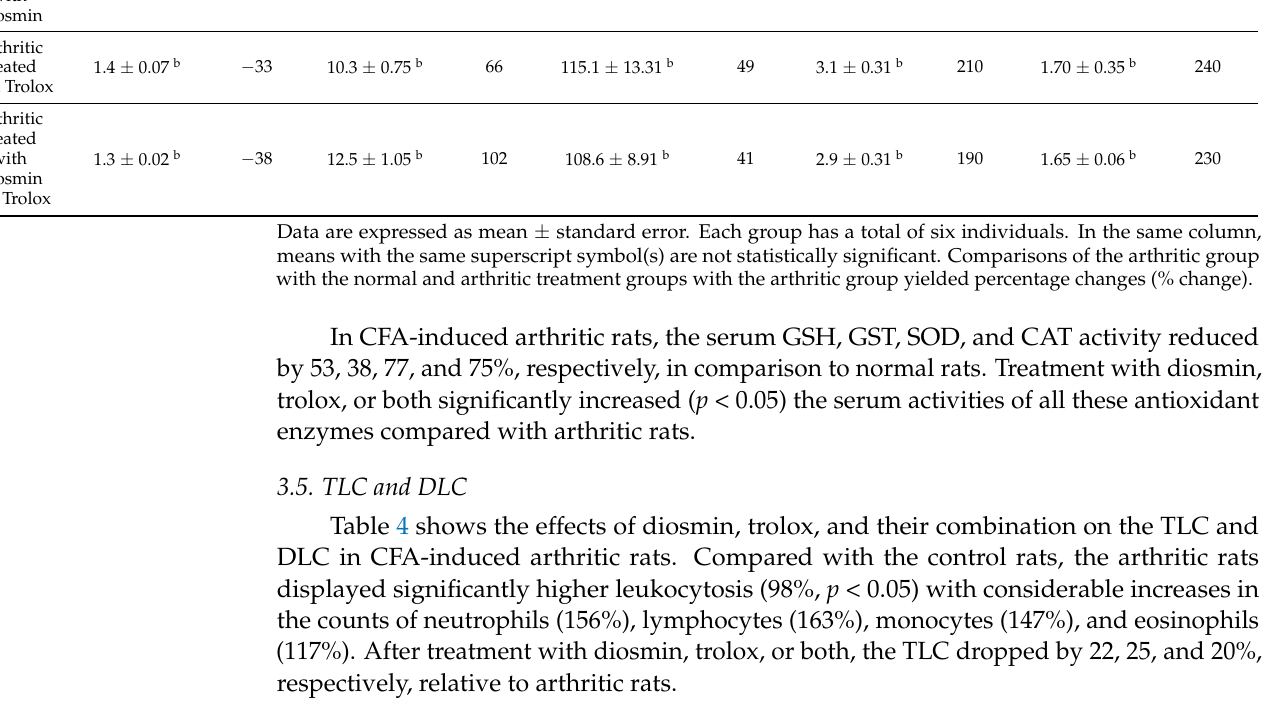
Table 4. Effect of diosmin and/ or trolox on TLC and DLC of CFA-induced arthritic